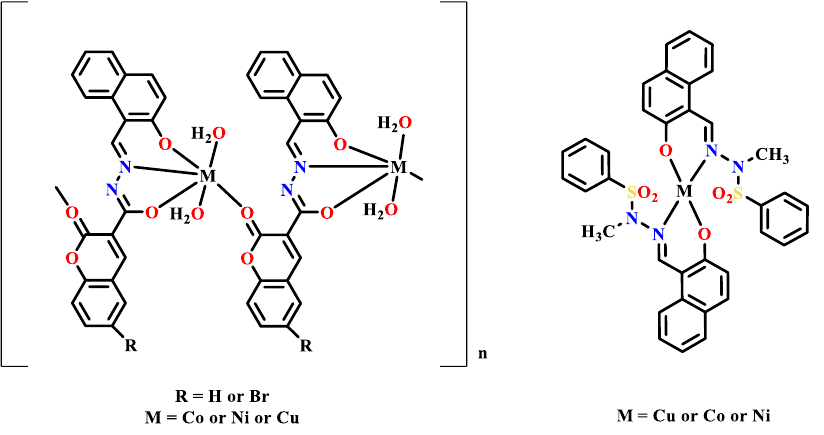
Figure 2. The Cu(II)/Co(II)/Ni(II) complexes of naphthylhydrazone with N -methyl benzene sulfon- amide as side chain. amide as side